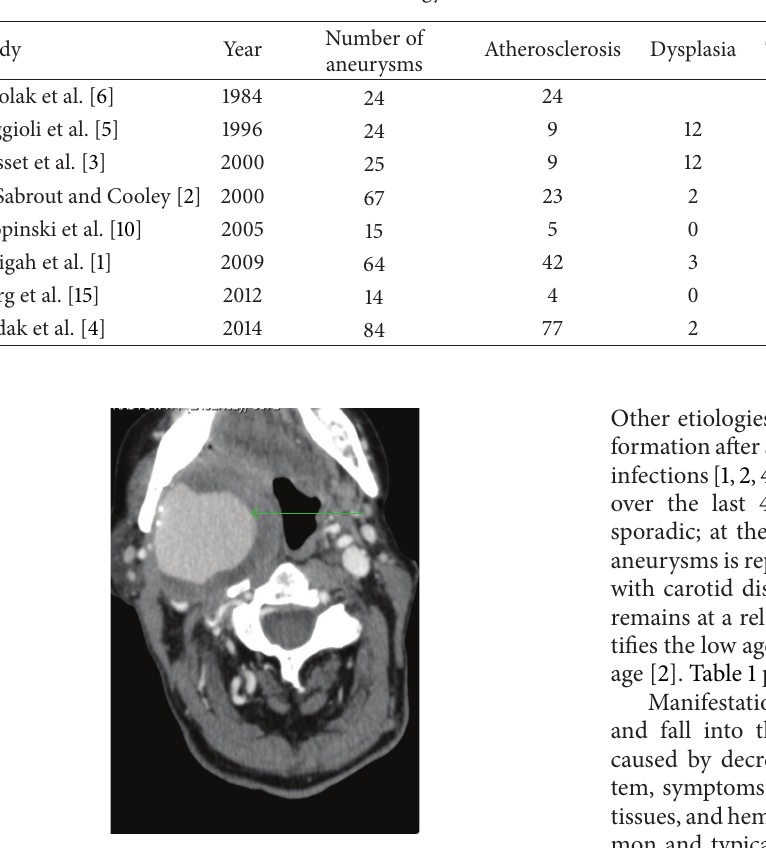
Table 1: Etiology of extracranial internal carotid artery aneurysms.